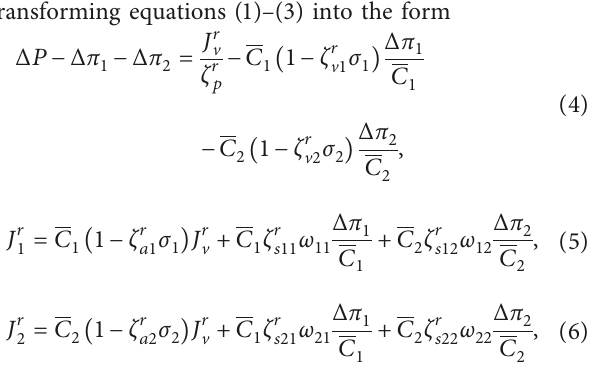
Figure 1: The model of single-membrane system: M, membrane; l A the concentration boundary layers in configuration B; P h and P l , mechanical pressures; C kh and C kl , concentrations of solutions; J A k and J A v , solute and volume fluxes in configuration A; and J B k and J B v , solute and volume fluxes in configuration